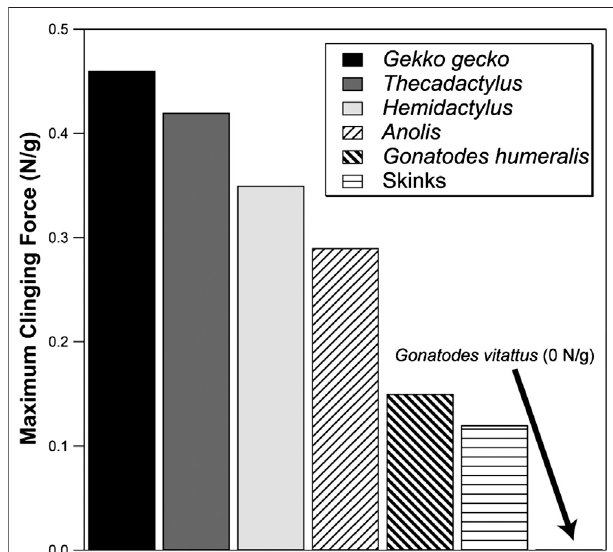
FIGURE 7 | Comparison of the maximum adhesive clinging abilities of lizards (recorded as Newtons per gram of body mass). Skinks exhibit very modest output. Anoles exert, at their greatest output, more adhesive force than skinks. Geckos maximally exert adhesive forces well above that of the best-performing anoles (although lesser-performing geckos overlap with the better-performing anoles). Gekko gecko represents the greatest adhesive output yet measured for geckos. In comparison, Gonatodes vittatus generates no adhesive attachment forces whereas G. humeralis performs as well as many anole species and approaches the lower end of the adhesive performance spectrum of geckos with toe pads. Data from Higham et al. (2017) and Irschick et al. (1996).